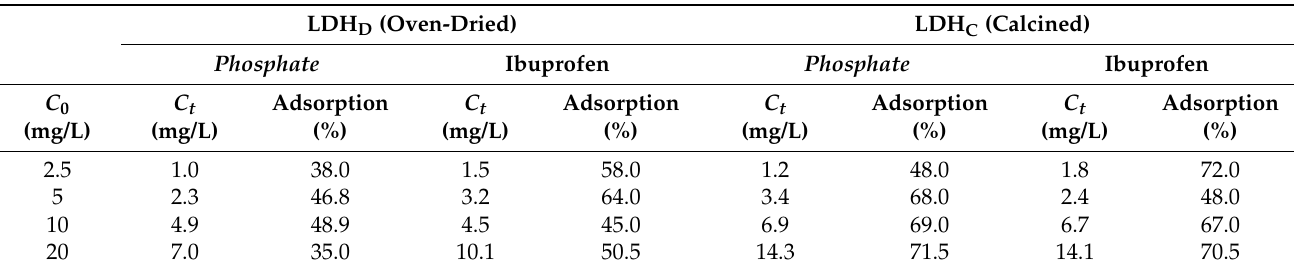
Table 3. Results for adsorption of mixed solutions containing phosphate and ibuprofen varying from 2.5 to 20 mg/L. Variation coefficients (%) of triplicates were under 10% in all